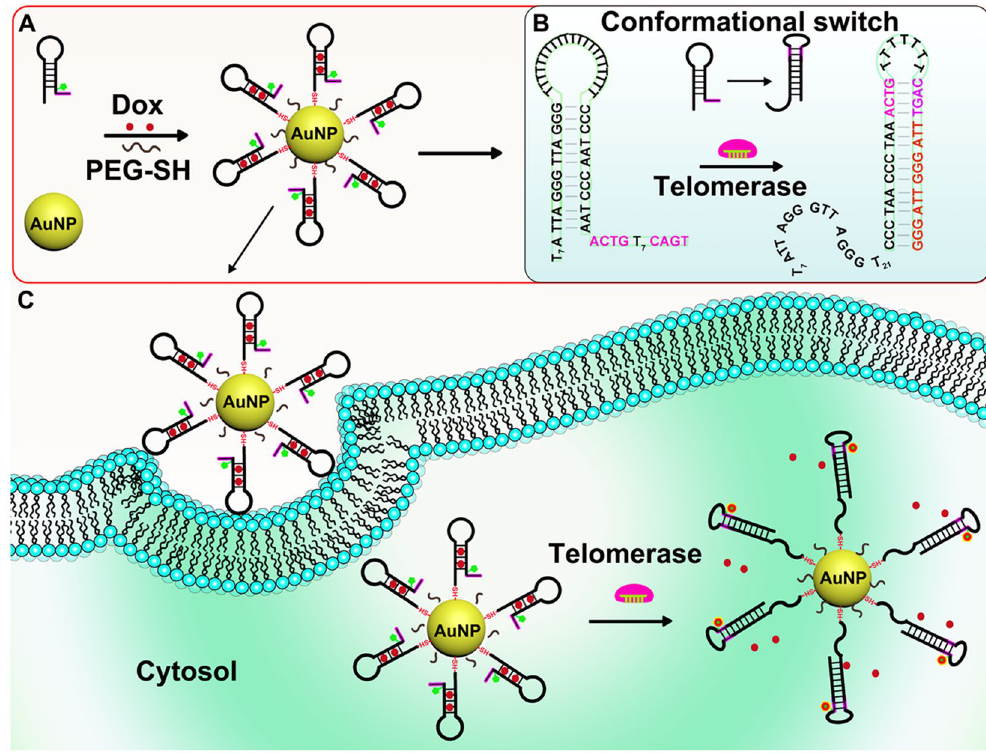
Figure 1. Schematic illustration of telomerase activity monitoring and drug release based on DNA conformational switch triggered by telomerase activity in living cells. ( A ) The synthesis procedure of AuNP- MPs. ( B ) The detailed conformational switch process. ( C ) The intracellular imaging and drug release based on DNA conformational switch initiated by telomerase